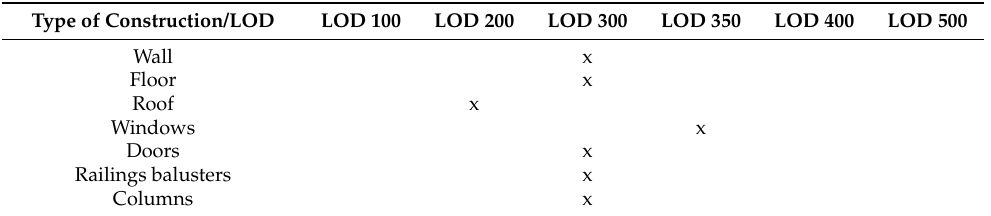
Table 3. Level of detail of individual object structures. Type of